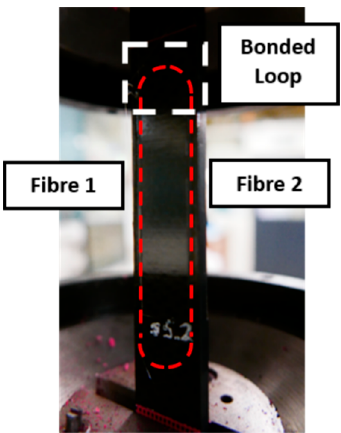
Table 3. Block loading regime—strain amplitude increased every 10 5 cycles starting at 1000 με .